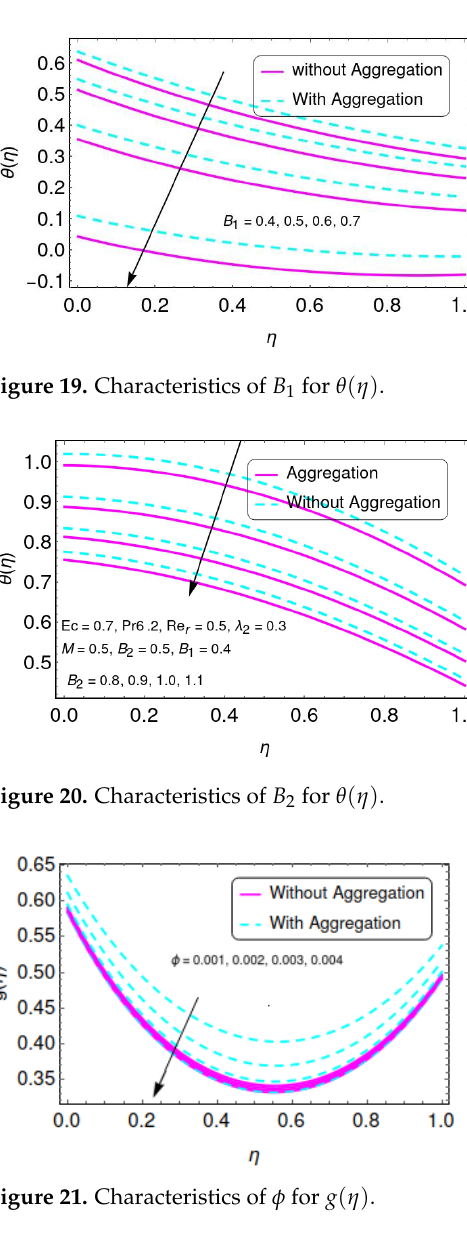
Figure 18. The result of Re r on θ ( η ) .